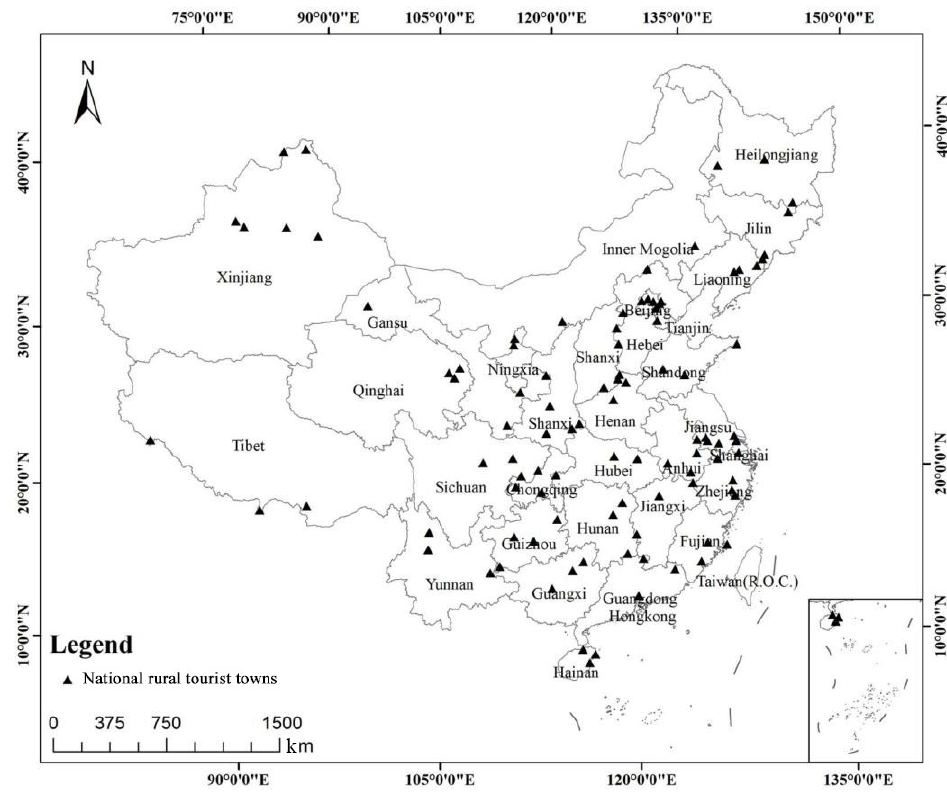
Figure 1. Geographic distribution of NRTTC.